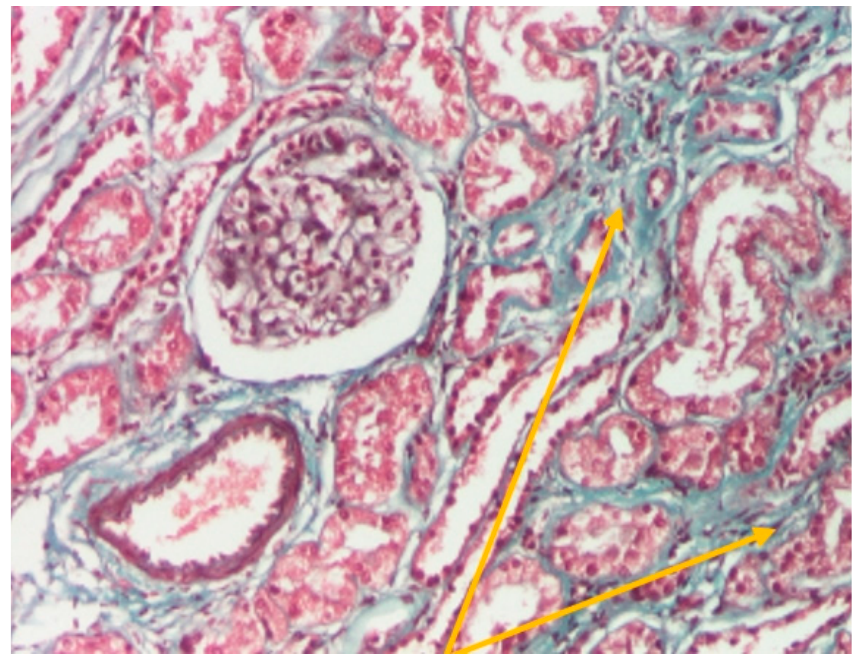
Figure 8. Hematoxylin-eosin staining ×200; renal tissue showing calci fi cations (blue arrows) (per- sonal collection, St. Mary Emergency Children’s Hospital, Iasi).